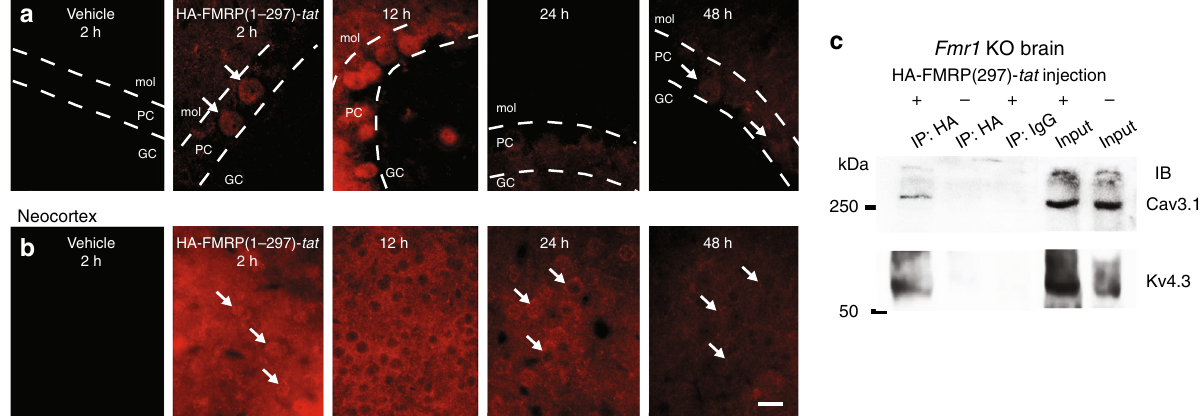
Fig. 5 HA-FMRP(1 – 297)- tat immunolabel persists at least 24 h in Fmr1 KO mice. a , b Qualitative comparison between HA immunolabel intensity in cerebellar tissue sections ( a ) or neocortex ( b ) prepared at the indicated times following tail vein injection of vehicle or 1.0 mg/kg HA-FMRP(1 – 297)- tat into P30 – P60 Fmr1 KO mice. All sections were reacted simultaneously with anti-HA antibody and imaged/processed at identical camera settings and light intensities to enable qualitative comparisons. Arrows identify the position of representative cells positive for HA immunolabel. c CoIP of HA-FMRP(1 – 297)- tat with Cav3.1 and Kv4.3 in brain lysates of Fmr1 KO mice 5 h after tail vein injection of HA-FMRP(1 – 297)- tat . IP was conducted using a mouse anti-HA antibody and mouse normal IgG (as control) and immunoblotting using rabbit anti-Cav3.1 and rabbit anti-Kv4.3 antibodies after an injection of 27 mg/kg HA-FMRP(1 – 297)- tat . All immunolabel data in ( a , b ) and coIP tests in ( c ) were derived from at least three different animals. Dashed lines in ( a ) denote cell layer boundaries. Scale bar for ( a , b ), 20 µ m. PC Purkinje cell layer, GC granule cell layer, mol molecular layer. Source data are provided as a Source Data fi